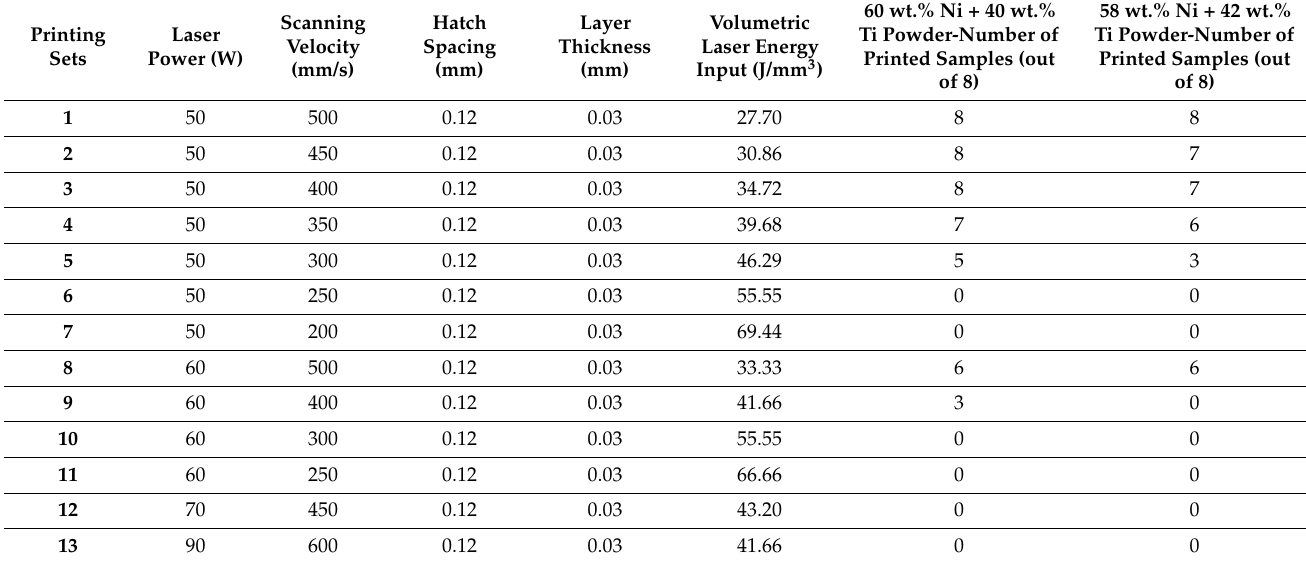
Table 3. Different sets of LPBF processing parameters used to print the cubic samples from